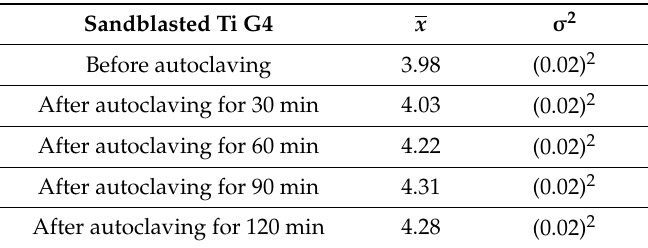
Table 10. Gaussian fitting parameters of the work function according to Equation (11) for the sandblasted Ti G4 before and after